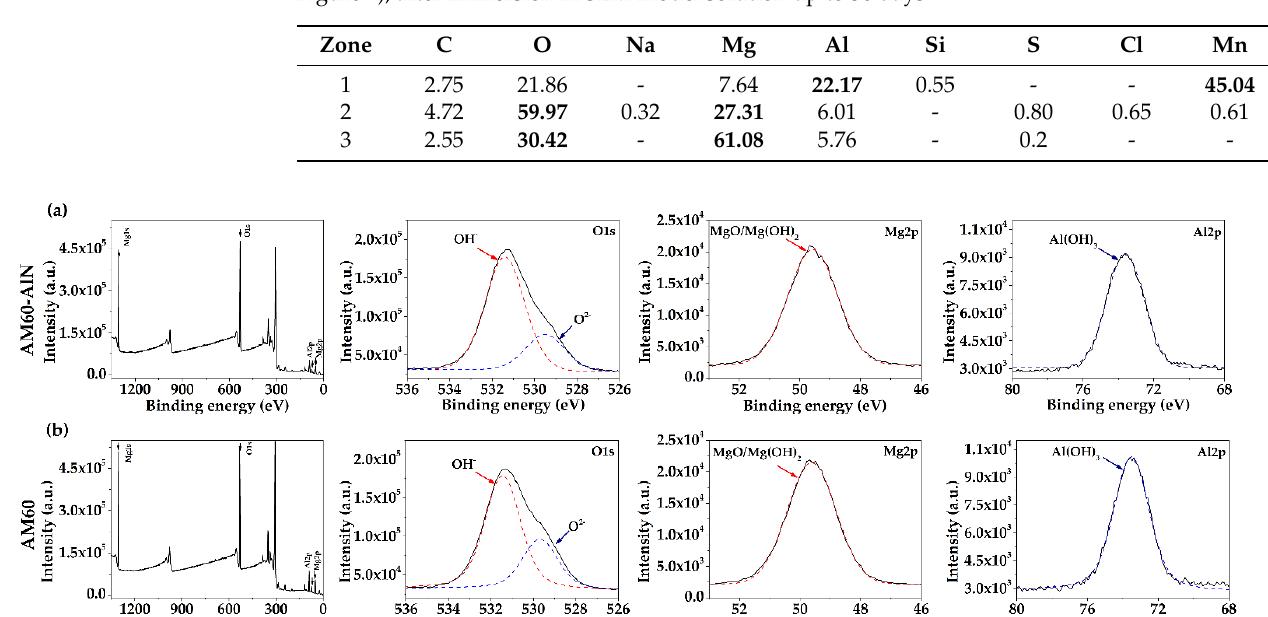
Table 3. EDS analysis (wt.%) of nanocomposite AM60-AlN and AM60 surfaces (in zones labeled in Figure 7), after immersion in SEM model solution up to 30 days. Figure 8. XPS spectrum of nanocomposite AM60-AlN ( a ) and AM60 alloy ( b ) at 30 days immersion in simulated marine-coastal environment (SME).